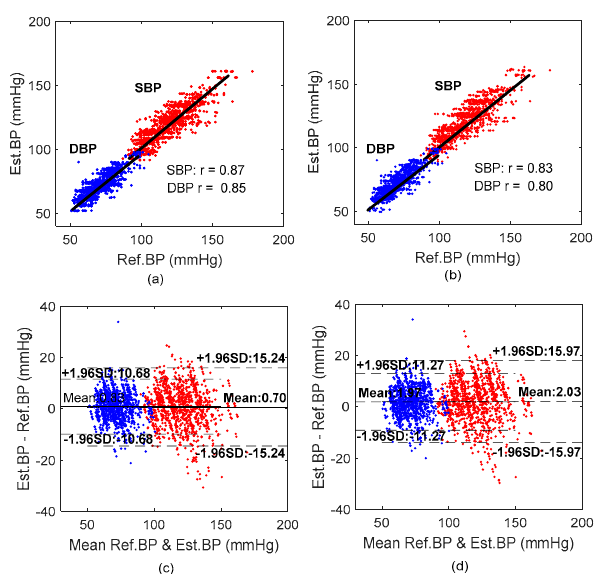
Figure 7. Correlation and Bland–Altman plots of SBP and DBP with the reference cuff-based BP. ( a , b ) Correlation between the reference and estimated BP. ( c , d ) Bland–Altman plot BP estimation. ( a , c ) From MPF-based model. ( b , d ) From PTT-based model.